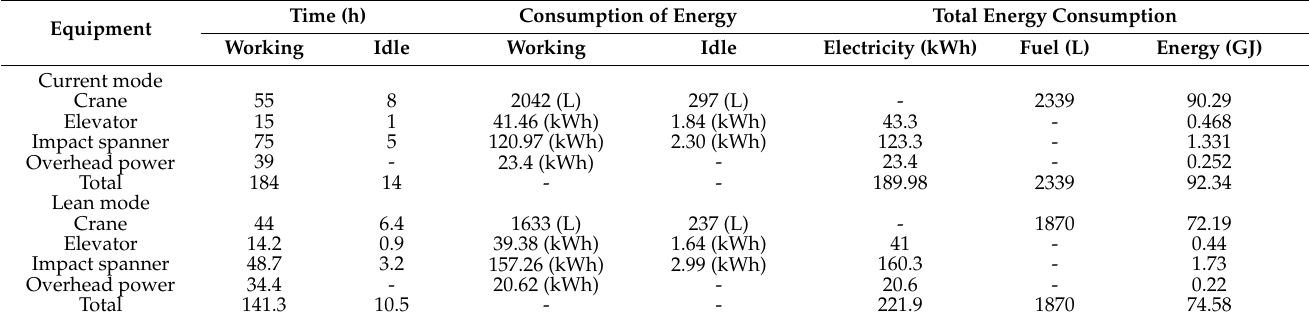
Table 7. Consumption of the energy during the construction processes of PSFs [45].